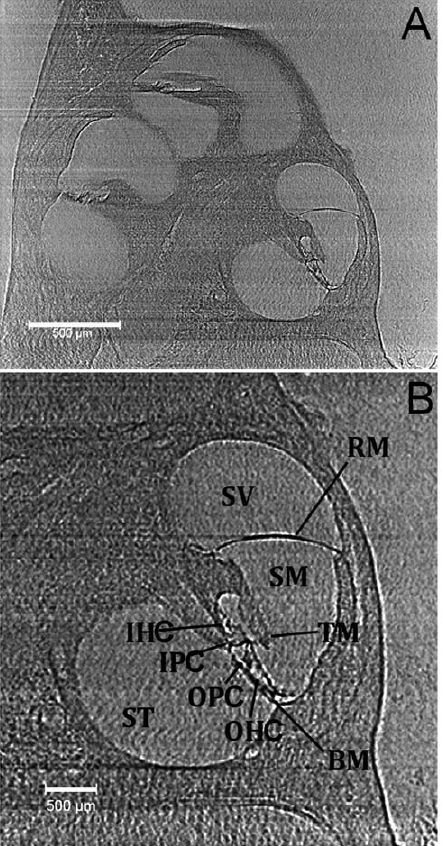
Figure 1. 2D slice from cochlear reconstruction. 1A: 2D slice of the reconstruction. The image shows three turns of the mouse cochlea, including scala vestibuli, scala media, scala tympani, Reissner’s membrane, tectorial membrane, organ of Corti, basilar membrane and stria vascularis. 1B: Magnified view of a cochlear turn. Clearly demonstrated and labeled are the scala vestibuli (SV), scala media (SM), scala tympani (ST), Reissner’s membrane (RM), tectorial membrane (TM), basilar membrane (BM), outer hairs cells (OHC), inner hair cells (IHC), outer pillar cells (OPC), and inner pillar cells (IPC).